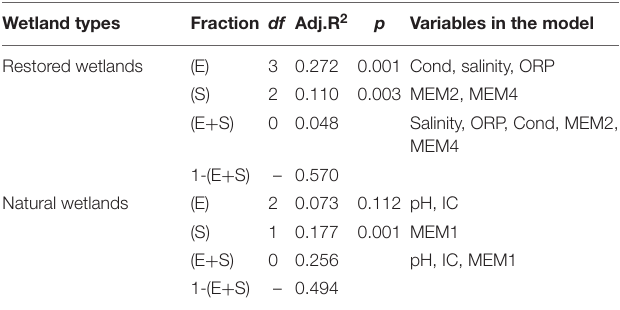
TABLE 2 | Results of variation partitioning, showing the contributions of spatial and environmental variables to the variation of restored and natural wetlands. Wetland types Fraction df Adj.R